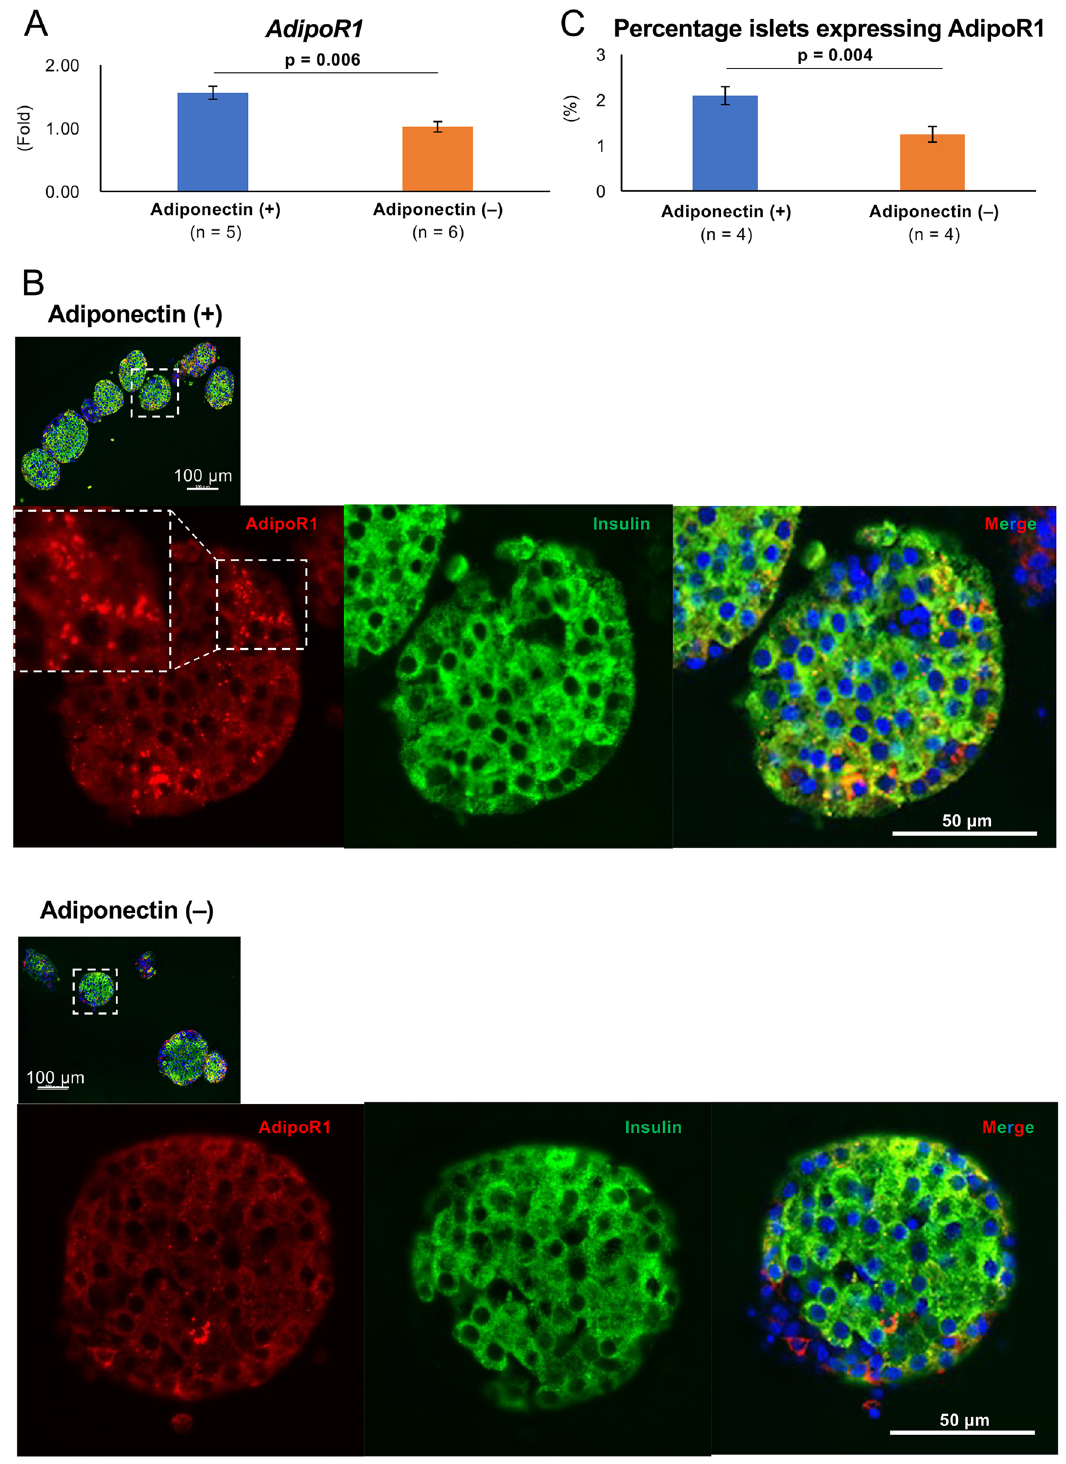
Figure 1. AdipoR1 expression on isolated islets. ( A ) AdipoR1 expression in islets with adiponectin treatment (adiponectin (+), blue) and without adiponectin treatment (adiponectin (−), orange) was quantified by qRT- PCR. The results were normalized to the β-actin housekeeping gene and were presented as the fold difference over the detectable Ct value, which was calculated using the ΔΔCt method. ( B ) Immunohistochemical findings of isolated islets in the adiponectin (+) group (upper) and adiponectin (−) group (lower) stained for AdipoR1 (red), insulin (green), and nuclei (blue, using DAPI). The AdipoR1 regions expressing β cells (yellow) are indicated by white triangles. Scale bar: 100 µm and 50 µm. ( C ) Quantification of AdipoR1-positive area per islet (percentage islets expressing AdipoR1). Data are presented as means ± standard error of the mean. A p -value < 0.05 was considered statistically